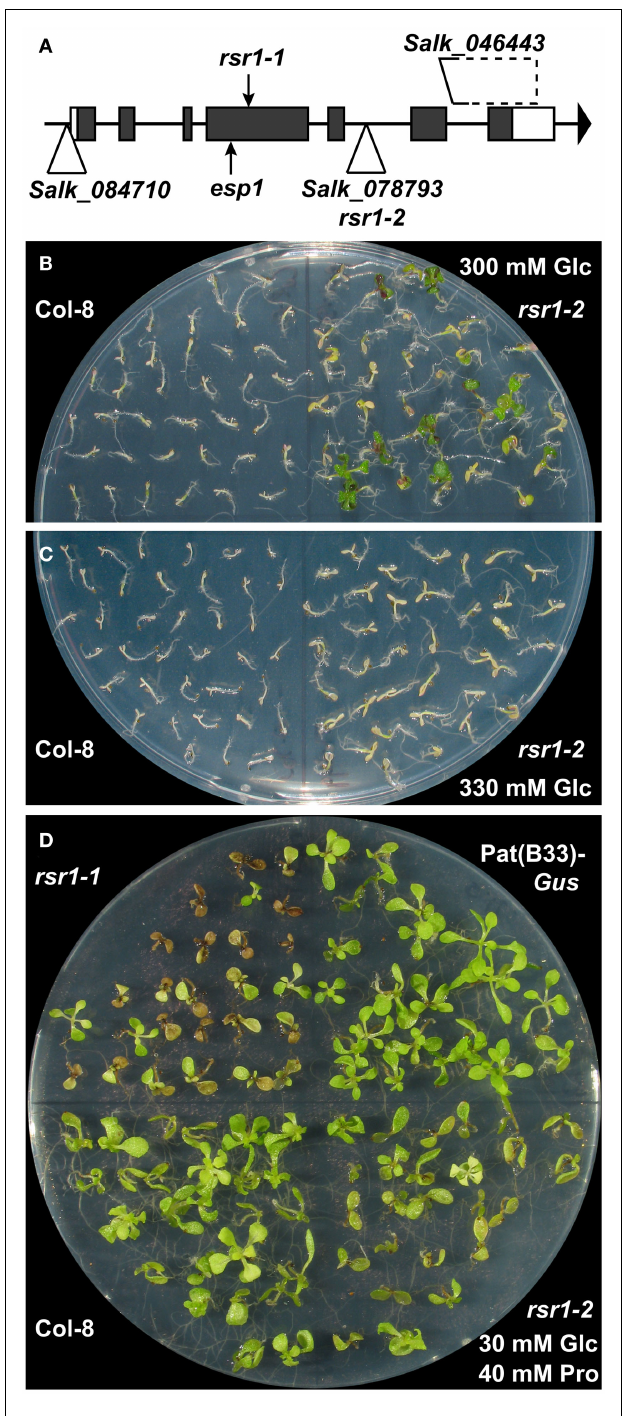
FIGURE 6 |AT-DNA insertion line of At1g73840 mimics rsr1-1 phenotypes. (A) Schematic drawing of the exon/intron structure of At1g73840 with the positions of the premature stop codons in rsr1-1 and esp1-1 alleles and insertion sites ofT-DNA lines analyzed in this study. (B) rsr1-2 mutants displayed increased tolerance to 300mM Glc compared to Col-8. (C) At 330mM Glc, also rsr1-2 plants were no longer able to establish autotrophic growth. (D) Like rsr1-1 , rsr1-2 mutants were hypersensitive to 40mM Pro in the culture